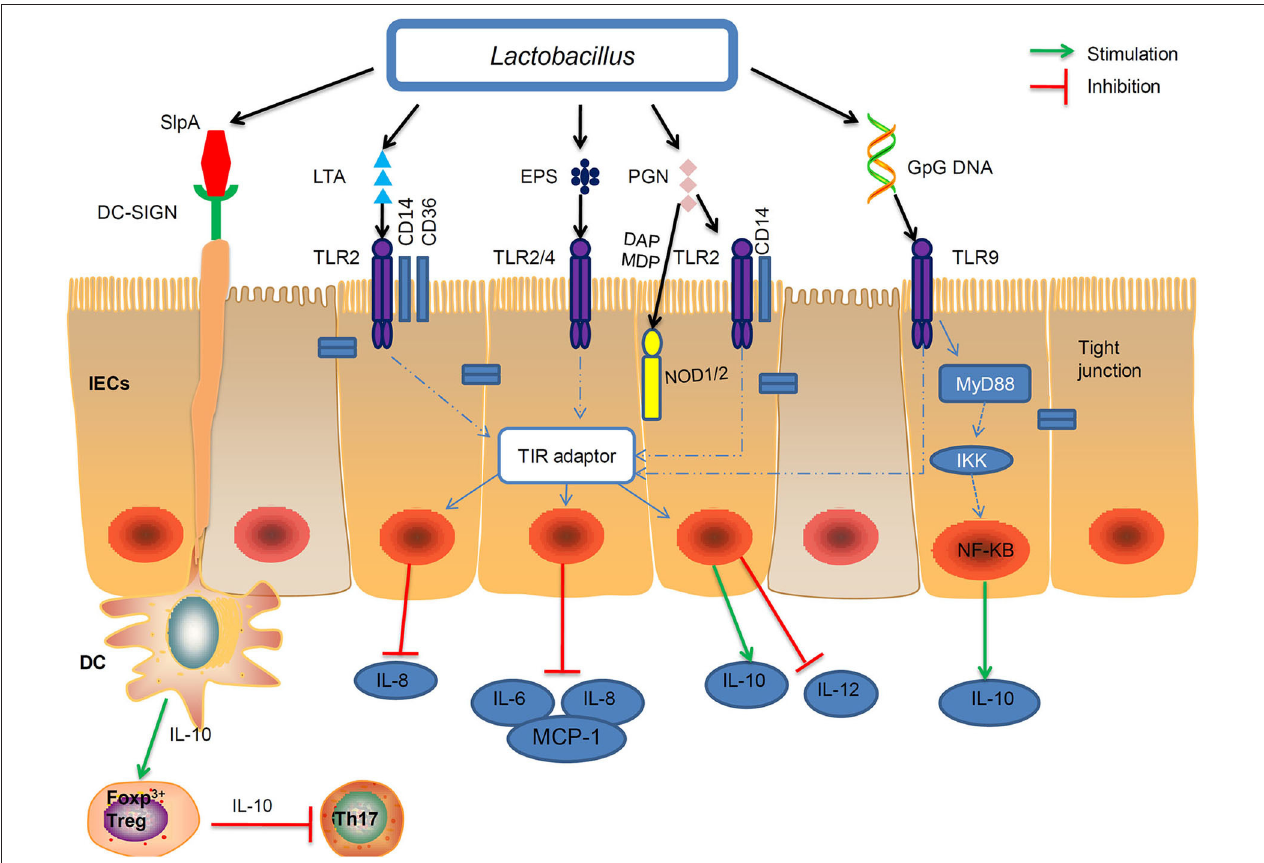
FIGURE 2 | Interactions of the MAMP of Lactobacillus with PRRs of the epithelial and immune cells of the host. Probiotic Lactobacillus possess conserved microbe-associated molecular patterns (MAMPs), including peptidoglycan, lipoteichoic acids (LTA), S-layer protein A (SlpA), exopolysaccharides (EPS), and genomic DNA which can be recognized by certain pattern recognition receptors (PRRs). Peptidoglycan and LTA interact with TLR2. Moreover, specific components of peptidoglycan, such as meso-DAP and MDP, are recognized by NOD1 and NOD2, respectively. The EPSs of L. delbrueckii TUA4408L, act as TLR2 and TLR4 ligands to exert anti-inflammatory activities by inhibiting the production of IL-6, IL-8, and MCP-1. On the apical side of IECs, CpG-DNA stimulated TLR9 interacts with MYD88 and the inhibitor of NF- κ B kinase (IKK) complexes, which may induced IL-10 expression. Binding of SlpA to the DC-SIGN (dendritic cell-specificICAM3-grabbing non integrin) receptor can induce IL-10 production in DCs and development of T cells. IEC, intestinal epithelial cell; DC, dendritic cell; Treg, T regulatory cell; Th, T helper cell; MCP-1, monocyte chemoattranctant